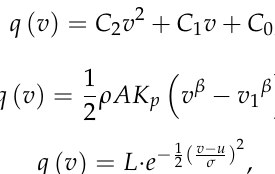
Figure 3. Power curve in which some of the anomalous data are marked.